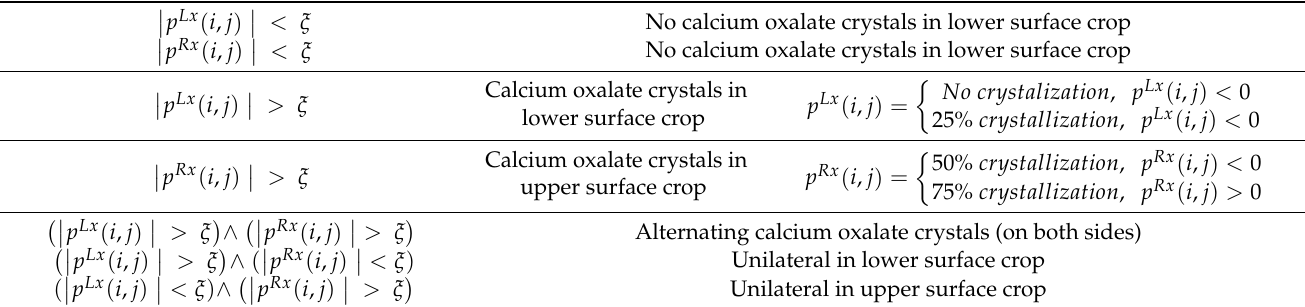
Table 2. Different classes of calcium oxalate